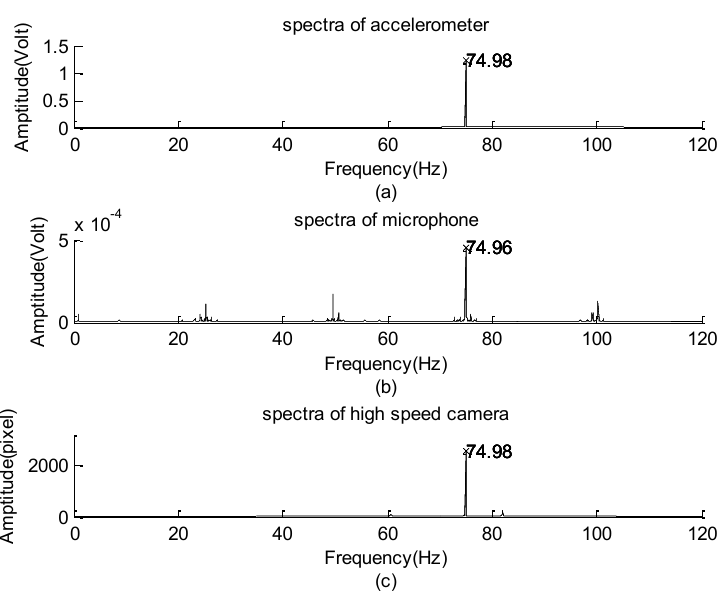
Figure 10. Comparison of the frequency response of the vibration exciter’s signal, input frequency is about 75 Hz: ( a ) spectra of accelerometer. ( b ) spectra of microphone. ( c ) spectra of high speed